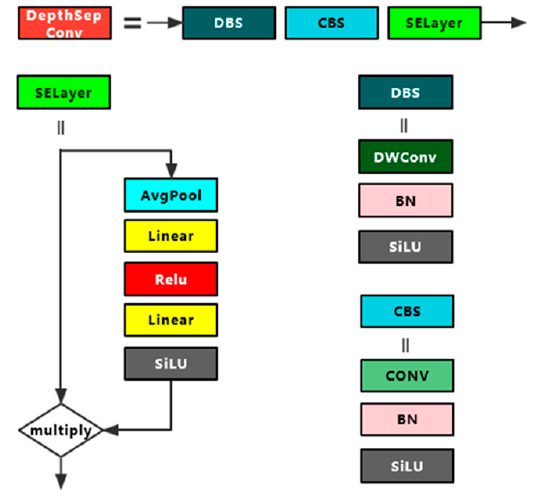
Figure 3. DepthSepConv module structure diagram.